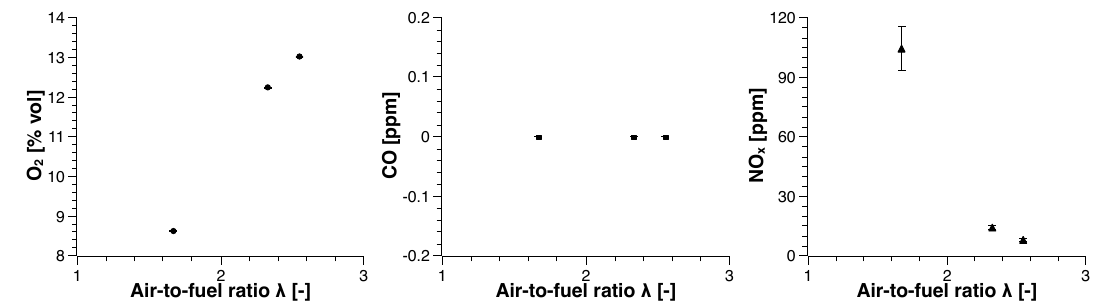
Figure 12. Concentrations of O 2 (% vol), CO (ppm), and NO x (ppm) as a function of air-to-fuel ratio λ . Air inlet temperature 600 ◦ C.